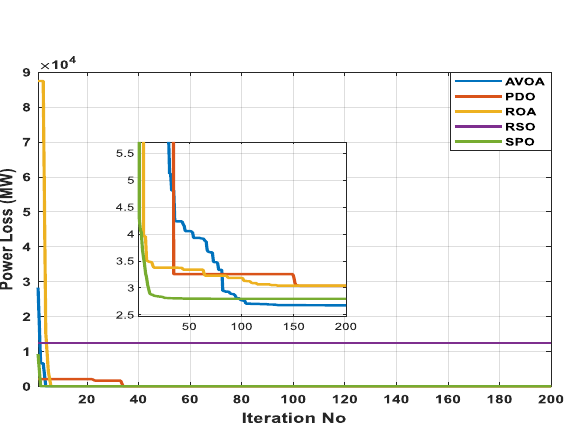
Figure 9. The AVOA convergence characteristics with the other compared methods for case 4.